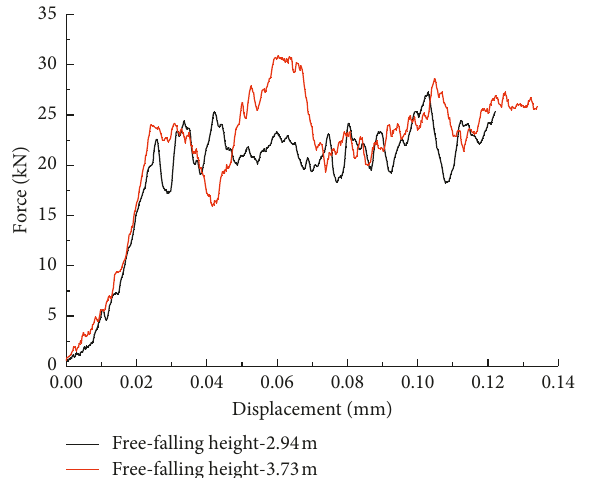
Figure 19: Dynamic tensile load-displacement curves of the symmetric tube-crushing dissipators.